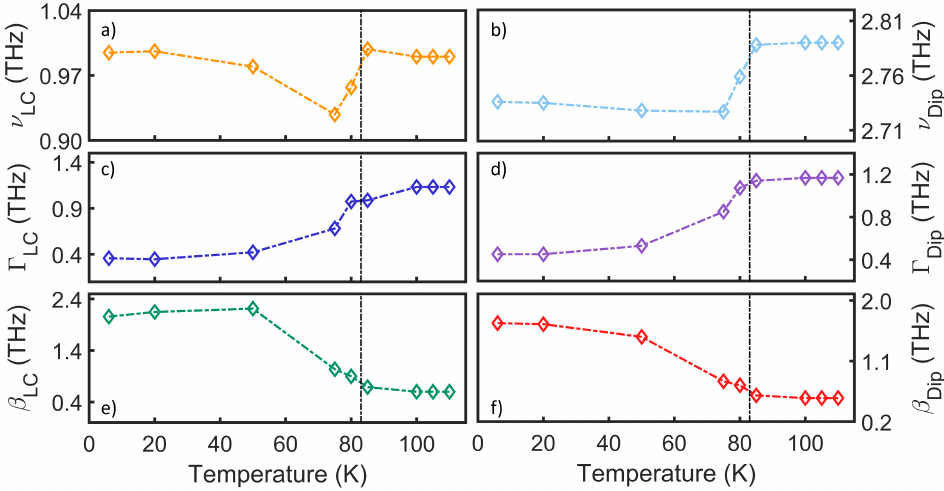
Figure 3. Fitting results (empty symbols) for the direct SRR device vs. T, as obtained by using Equation (1) applied to data in Figure 2a. The dashed color lines are a guide for the eyes. Error bars correspond to the size of diamond symbols. Panels ( a , c , e ) show the resonance frequency ν LC , the line width Γ LC , and the coupling coefficient β LC of the LC resonance; ( b , d , f ) show the the same quantities for the dipolar resonance. The black vertical point-dashed lines underline the YBCO critical temperature T c = 83 K.